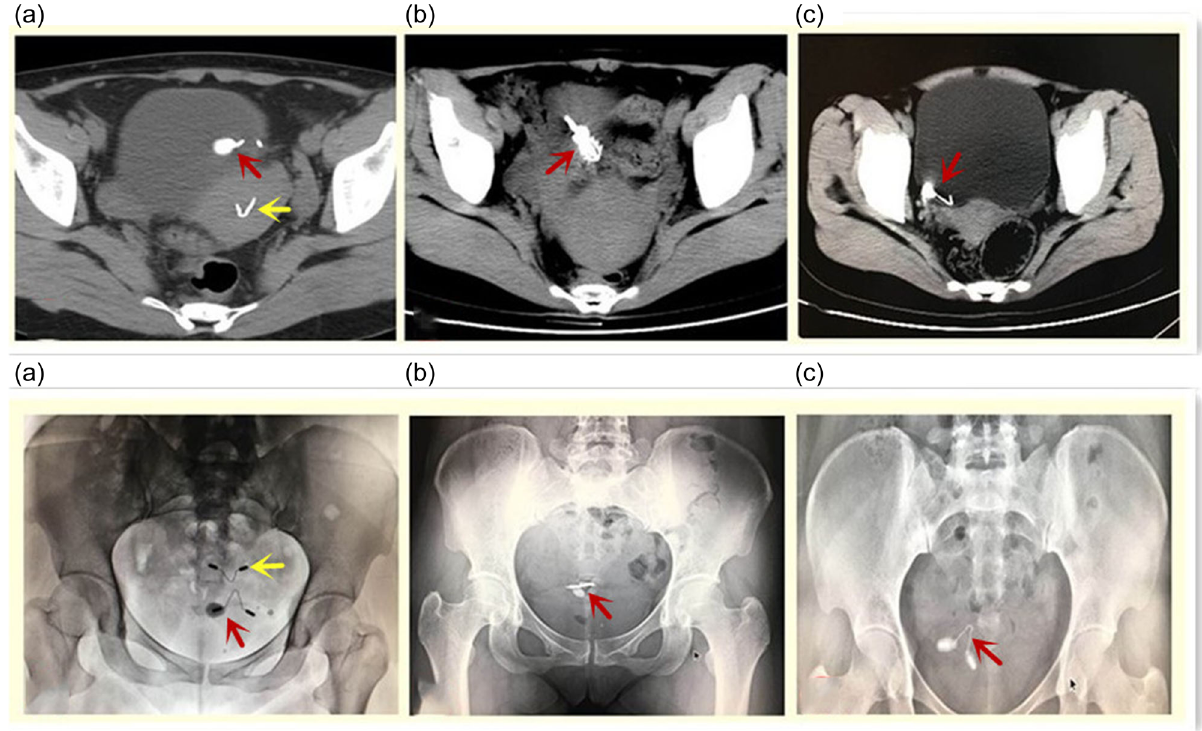
Figure 1: The ectopic IUD was examined by pelvic radiography and computed tomography ( CT ) and was found to be embedded in the bladder wall and wrapped with a calculus. ( a ) A 34 - year - old patient, gravida 2, para 2 ( case #1 ) . The patient got pregnant after IUD insertion. After the induced abortion, a new IUD was inserted. The patient su ff ered from abdominal pain and hematuria for half a year. Two IUDs can be seen, one is in the uterus ( yellow arrow ) , and the other is embedded in the left posterior wall of the bladder ( red arrow ) . ( b ) A 33 - year - old patient, gravida 2, para 1 ( case #2 ) . The patient su ff ered from abdominal pain and hematuria for 1 year. The ectopic IUD was completely embedded in the posterior wall of the bladder ( red arrow ) . ( c ) A 34 - year - old patient, gravida 2, para 2 ( case #5 ) . The patient su ff ered from intermittent hematuria and urodynia for 9 months. The IUD was completely shifted in the bladder ( red arrow )